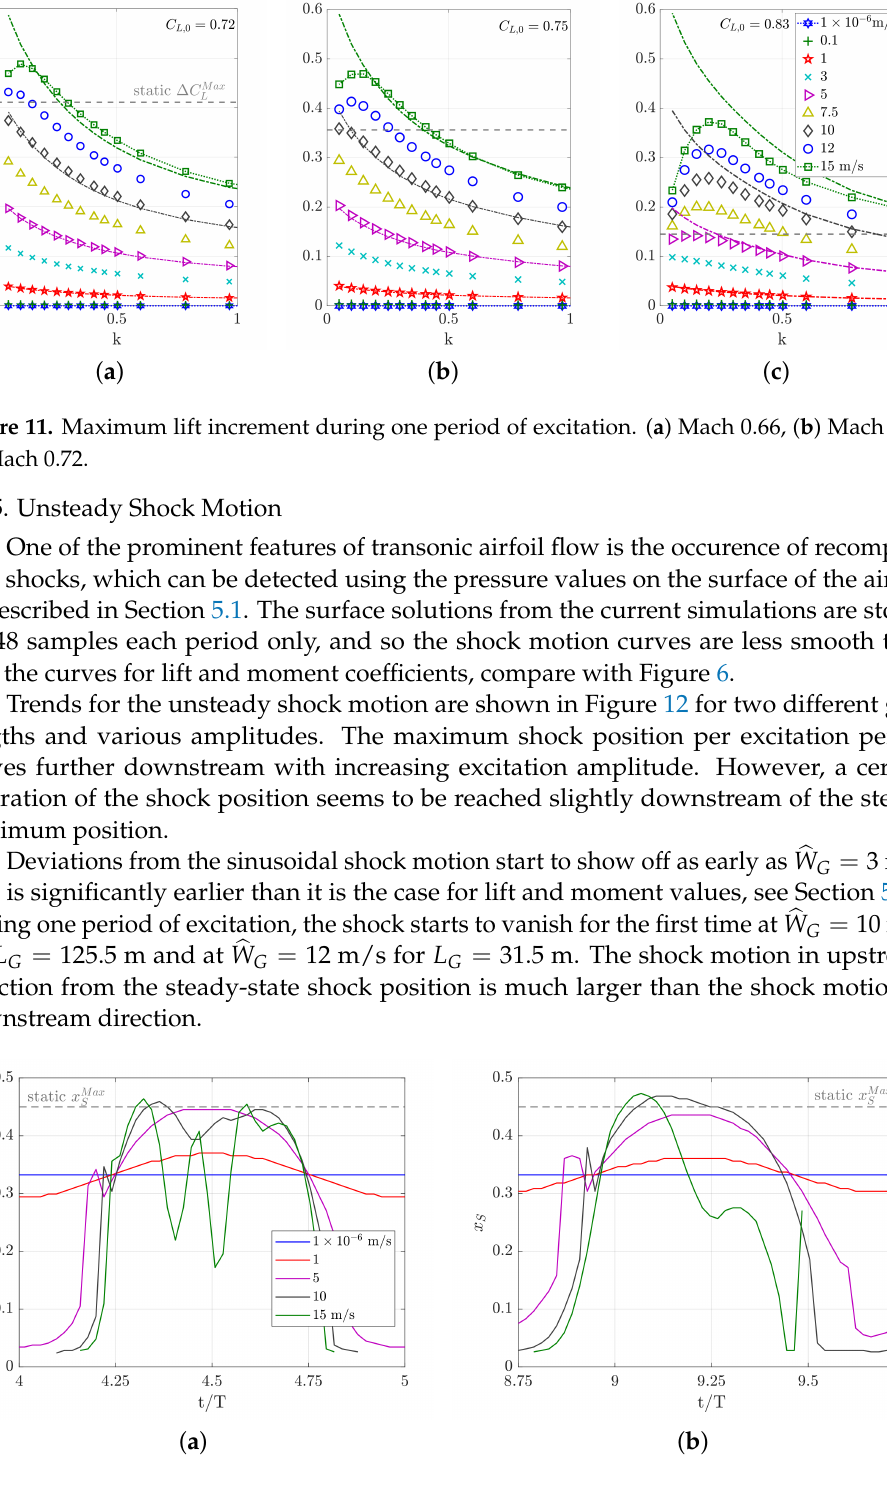
Figure 12. Shock motion for two gust lengths and various amplitudes at Mach 0.70. ( a ) L G = 125.5 m (k = 0.05), ( b ) L G = 31.5 m (k =